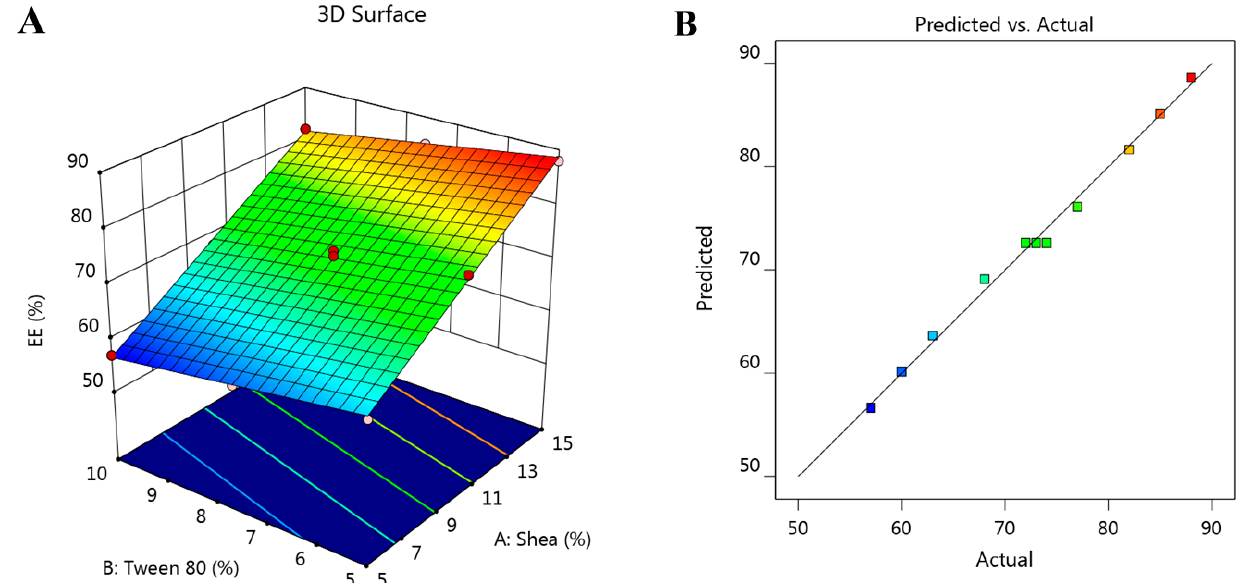
Figure 2. ( A ) The 3D-response surface graph showing the influence of independent factors, shea and Tween 80 concentrations, on the investigated EE (R 2 ), and ( B ) linear correlation plot between predicted and actual values validating the effect of various independent factors on EE response (R 2 ).